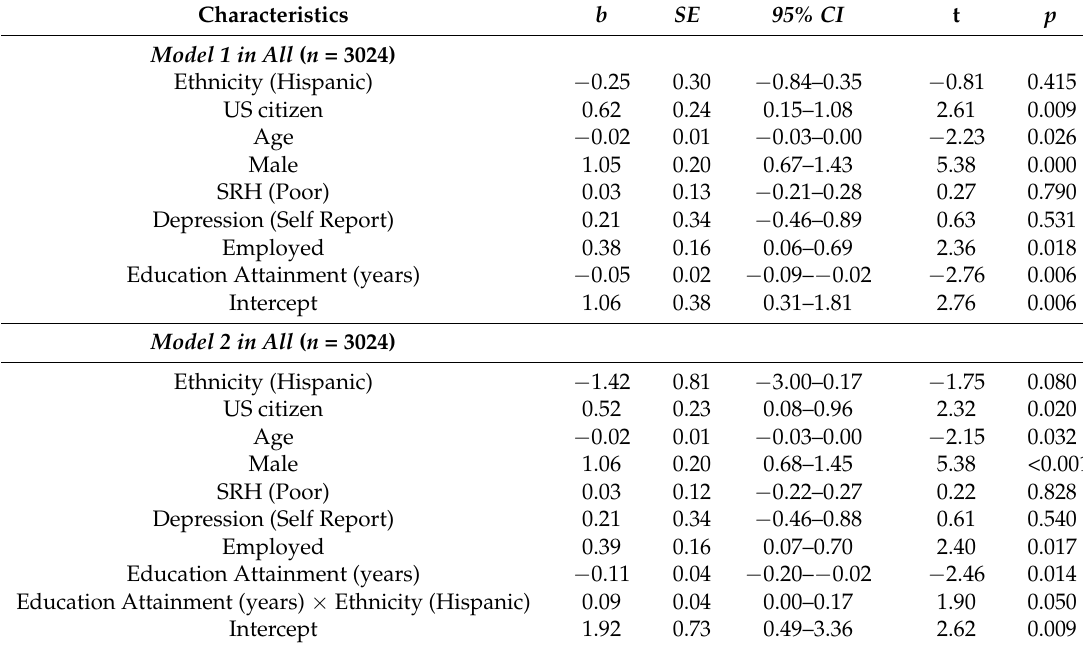
Table 3. Results of two linear regression models in the pooled sample.